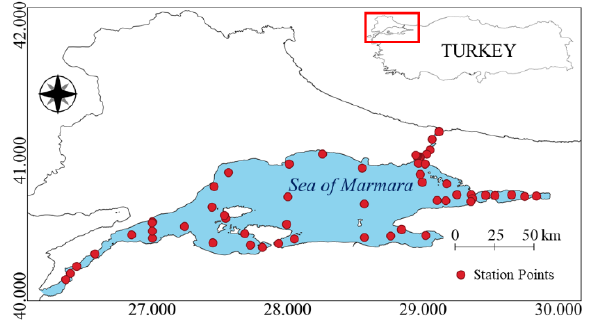
Figure 1. The study area.